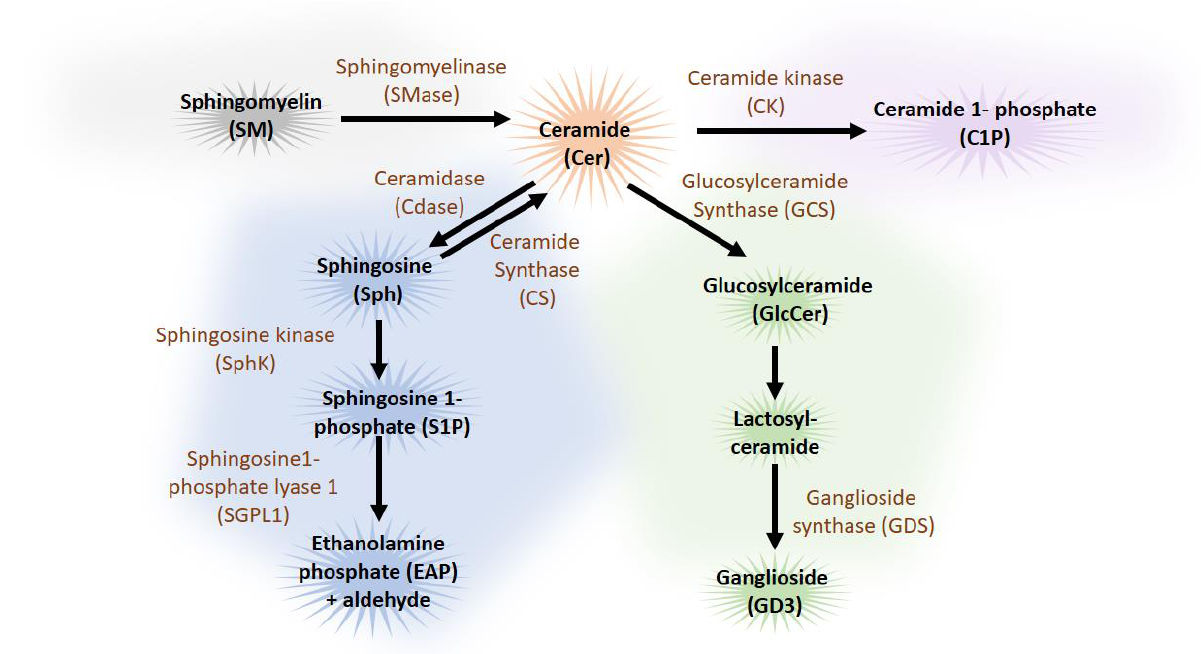
FIGURE 4: Overview of sphingolipid metabolism pathway . Ceramide (Cer) occupies a central position in the catabolic (blue), the sphingo- myelin (grey) and hydrolytic (green) sphingolipid pathways. Apart from the de novo synthesis, ceramide can also be synthesized from sphin- gomyelin (SM) by sphingomyelinase (SMase) or from sphingosine (Sph) by ceramide synthase (CS). Cer can be catabolized to the biologically active metabolites, sphingosine (Sph) and sphingosine 1-phosphate (S1P) and further catabolized to ethanolamine phosphate (EAP) and C16 fatty aldehydes by ceramidase (Cdase) by the sphingosine kinase (SphK) and sphingosine1-phosphate lyase 1 (SGPL1) respectively. Cer can also be hydrolysed by glucosylceramide synthase (GCS) to glucosylceramide (GlcCer) and by ganglioside synthase (GDS) to ganglioside (GD3), a complex glycosphingolipid. Phosphorylation of Cer by the ceramide kinase (CK) produces ceramide-1-phosphate (C1P). Sphingolipids are coloured in black and enzymes are coloured in brown. (Note only autophagy relevant parts of the sphingolipid pathways are